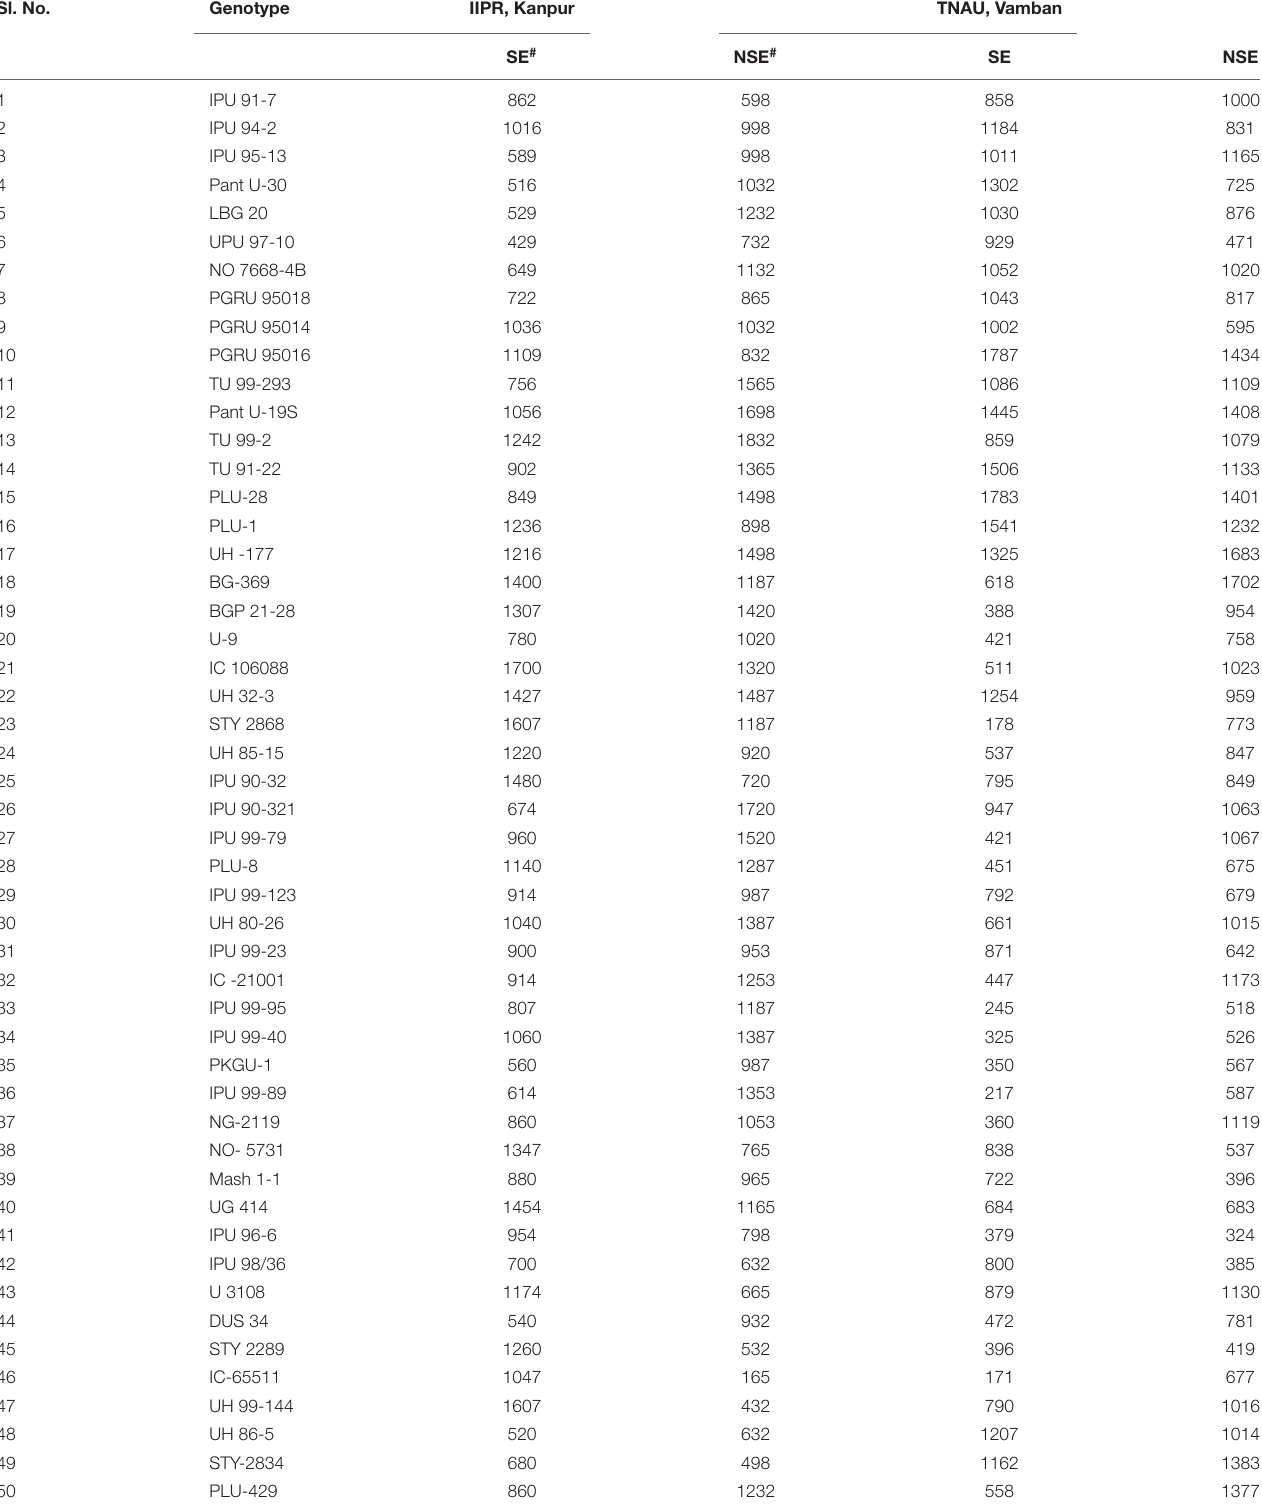
TABLE 1 | Yield of 97 urdbean genotypes grown in IIPR, Kanpur and TNAU, Vamban. Sl.